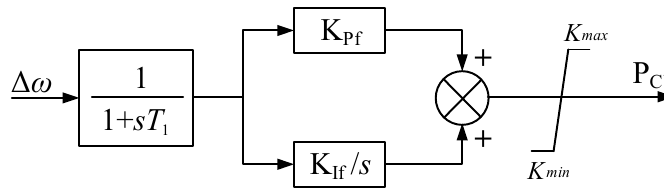
Figure 11. Speed controller model under FCB